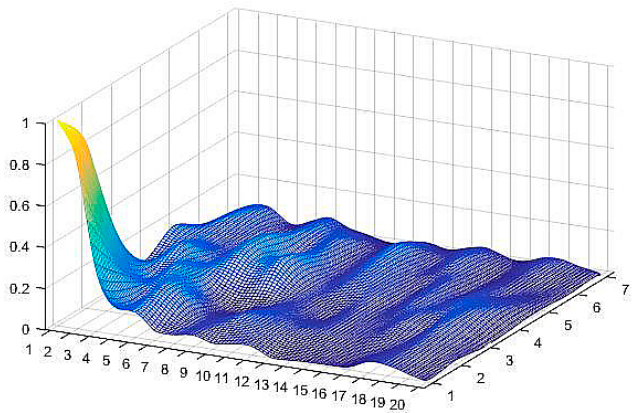
Figure 4. Pattern neurons’ distance–weights distribution diagram (distance–weights are regularized by the max–min method, labels on the x axis and y axis are the indices of reference points (RPs)). Instead of utilizing a complex algorithm such as clutering, we determined the category quantity C according to Equation (13).